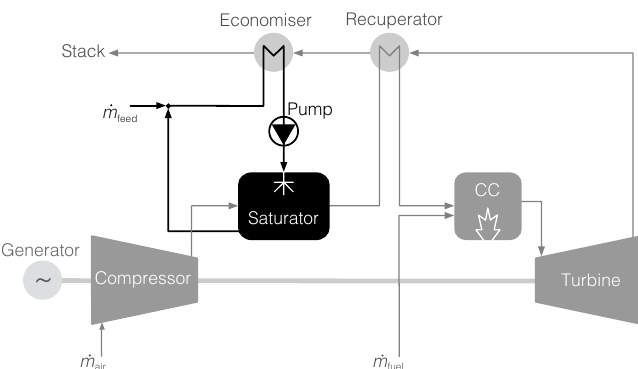
Figure 1. By introducing a saturation tower and a humidification unit (shown in black), the mGT cycle (in grey) is transformed into an mHAT.